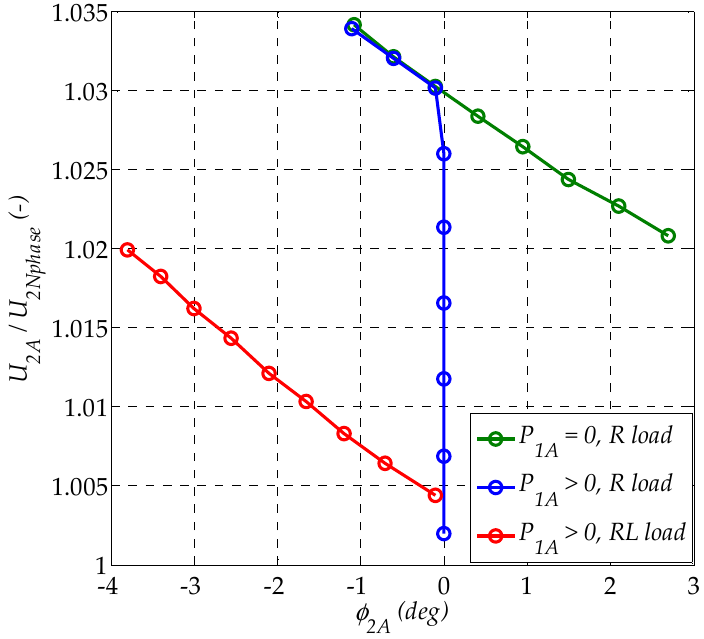
Figure 8. Relationship between the RMS value of U 2A and its phase angle φ 2A of the control system. The control effects in the control system from Figure 5, in static terms, are presented in Figures 9 and 10 for the resistive load of two phases of the transformer secondary side and for the resistive–inductive load (p.f. = 0.8) of these phases. The analysis of Figures 9 and 10 shows that the operation of the control system in Figure 5 cannot be considered as fully sat- isfactory. The problem is the active power of phase B of the primary side of the transformer. This can be seen especially in Figure 10, this power can be negative, i.e., returned to the MV grid. This is due to the fact that this power is not controlled. By the amplitude and phase of the sinusoidal voltage of the prosumer source, only the active power of the A phases of both sides of the transformer is controlled. The active powers of B and C phases are not controlled, just as the reactive powers of all phases of both sides of the transformer. Perhaps it is not possible to control these powers using only two control variables (the amplitude and the phase of the prosumer voltage). As can be seen in both figures, the control system works correctly in the sense of the control requirement P 1A ≥ 0. The primary C phase active power is always constant and proportional to the secondary C phase active